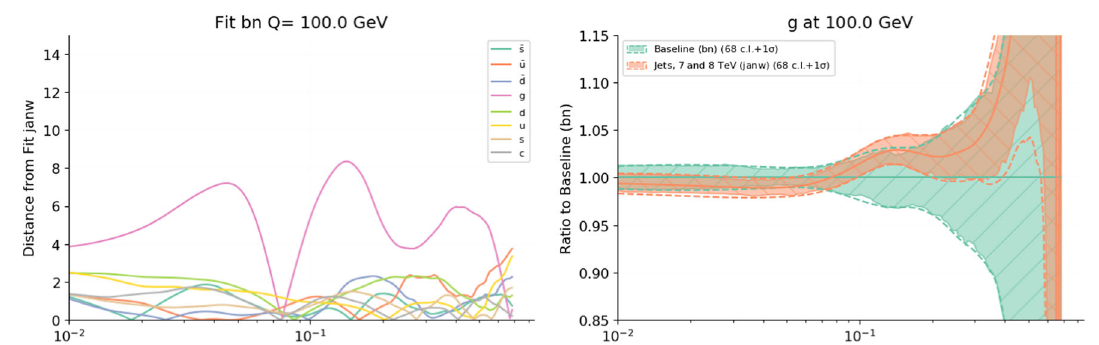
and the ratio of the gluon PDF to the baseline (right) are shown at the scale Q = 100 GeV. The shaded band is the 68% confidence interval, while the dashed lines are the edge of one sigma